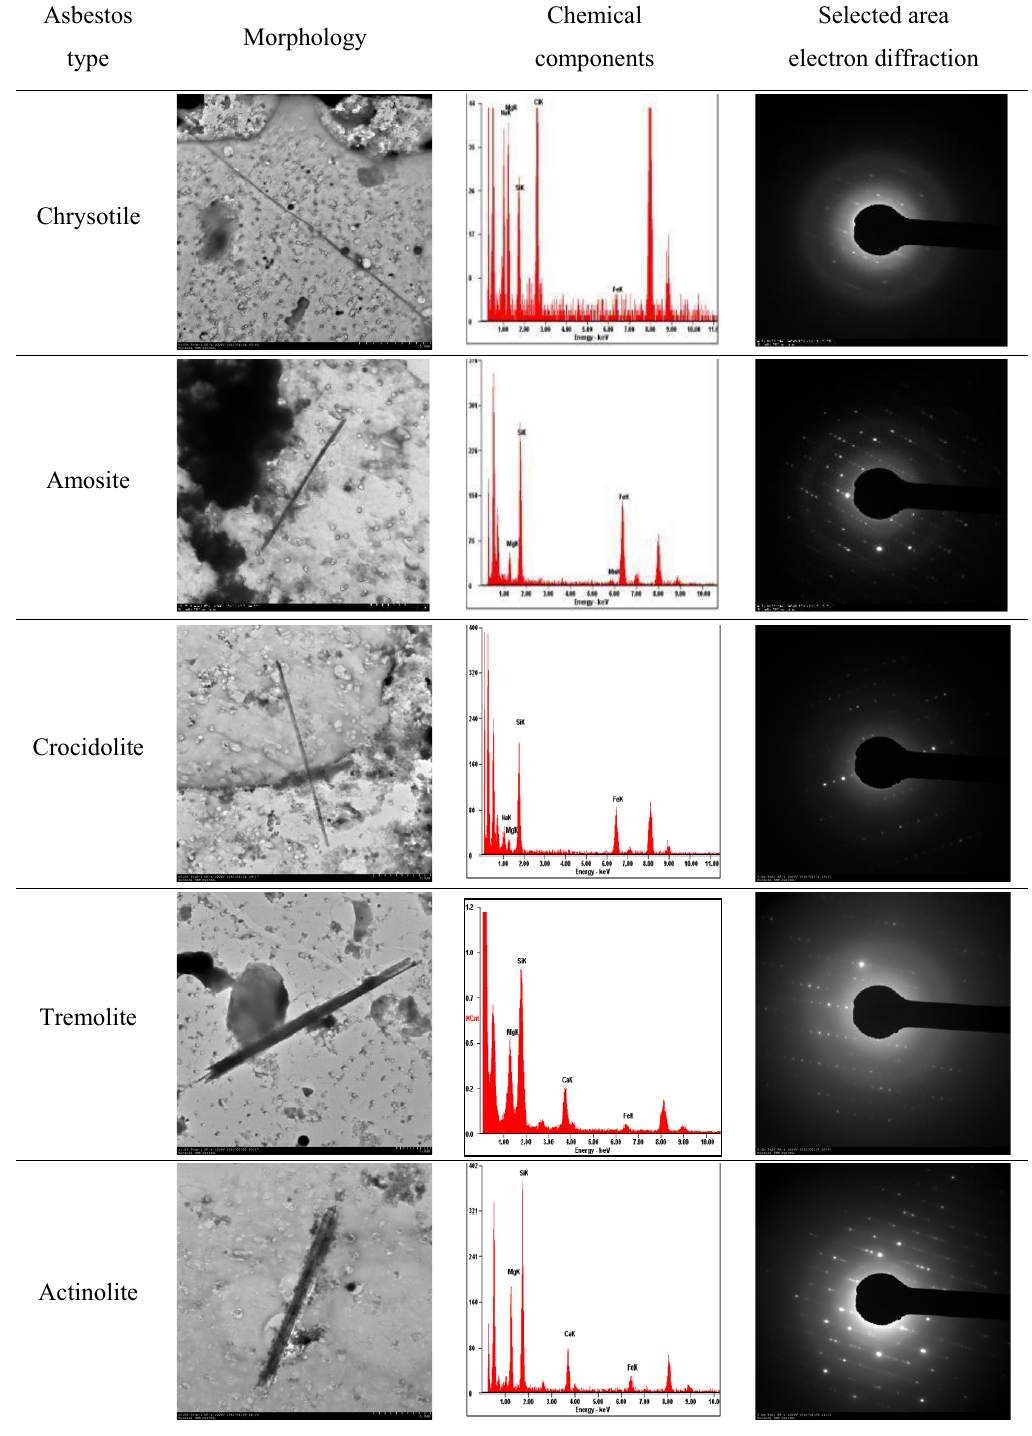
Table 5. Morphology, chemical components (via energy-dispersive x-ray spectrometer), and selected area electron diffraction of detected asbestos fibers in lung